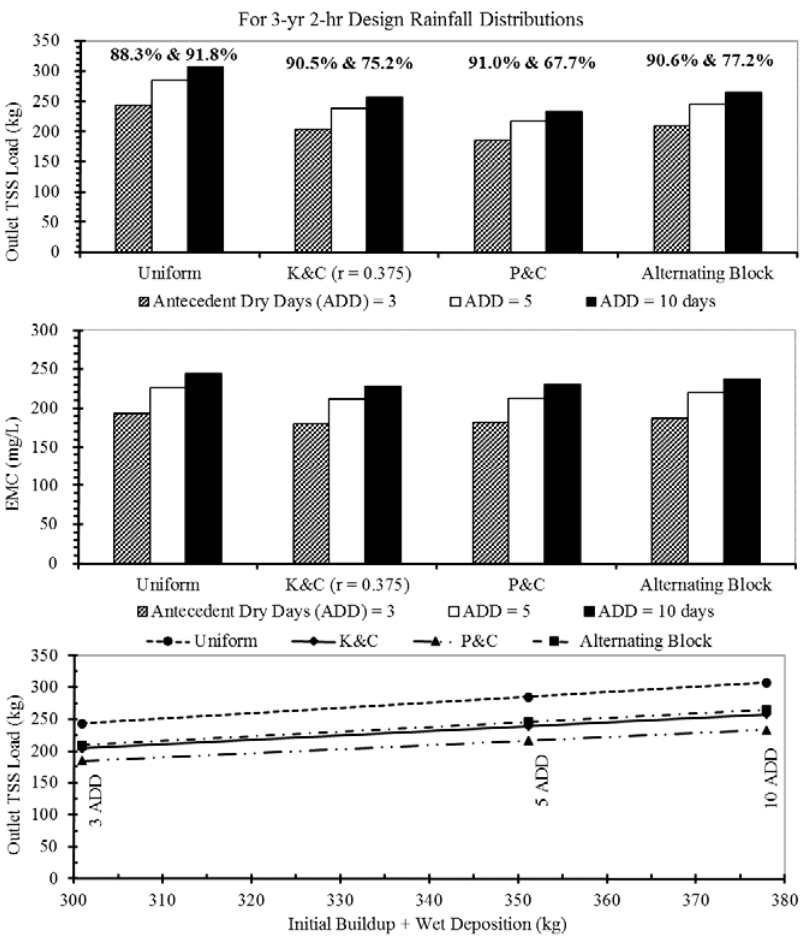
Figure 9. Simulated outlet TSS load (kg) and event mean concentration (EMC) of outlet TSS (mg/L) under three different antecedent dry ‐ day periods for four three ‐ year, 2 ‐ h design rainfall